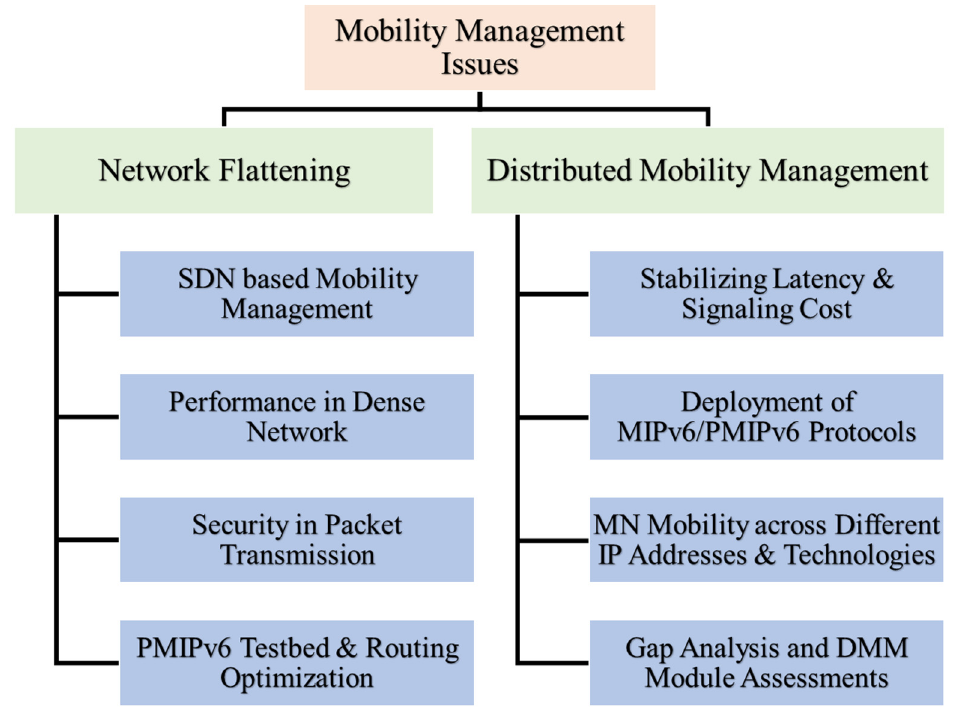
Figure 3. Mobility management issues.